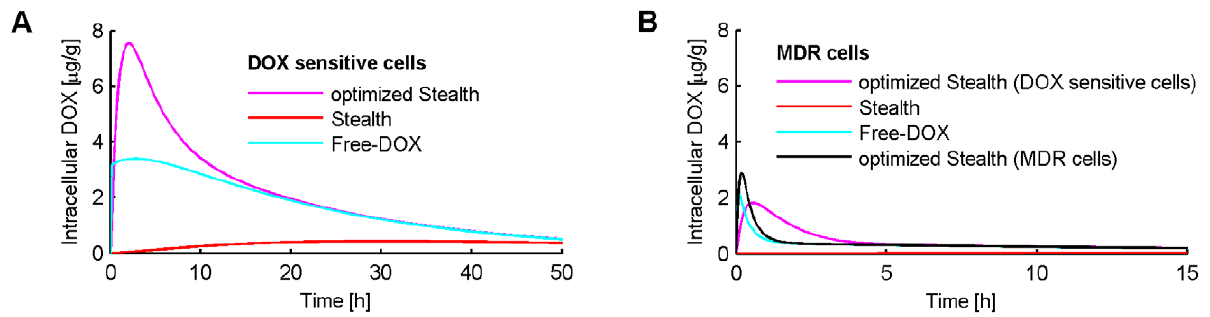
Figure 8. (A) Comparison of Free-DOX , Doxil ( t =454.4 h), and optimized Stealth liposomes ( t =45 min) in DOX-sensitive cells, showing intracellular concentration time course. (B) Considerably lower intracellular concentrations are achieved with same formulations in MDR cells. Further, the optimal liposomal release time constant is considerably lower ( t =4 min) for MDR cells.